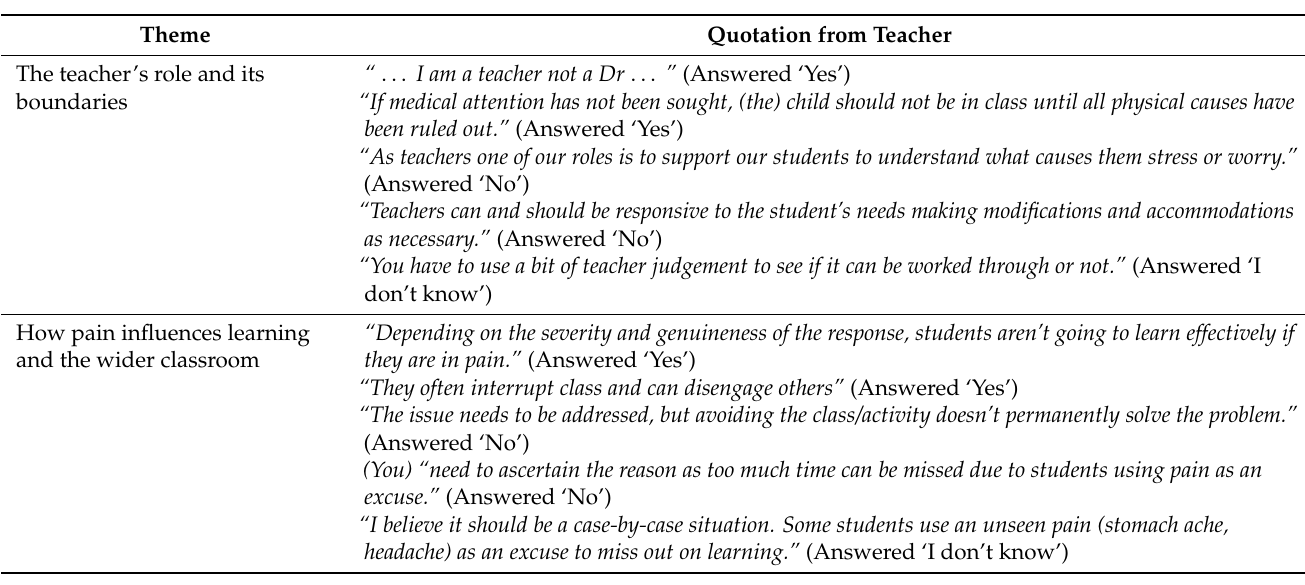
Table 4. Quotations to illustrate the themes from teacher responses: ‘Do you think students who report pain should not attend